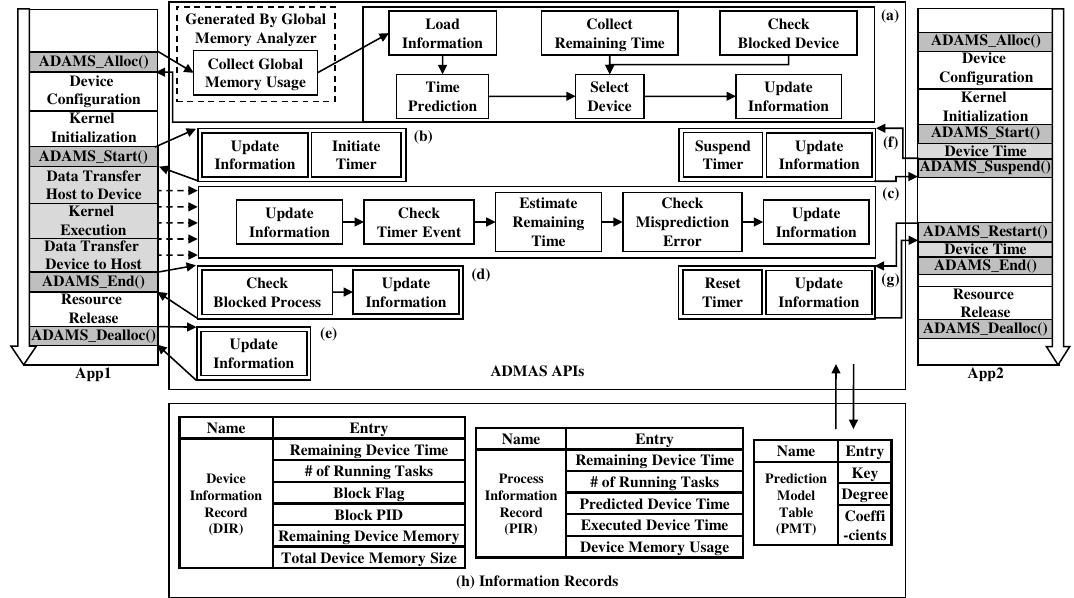
Figure 5. An overview of ADAMS framework, ( a – g ) API descriptions, ( h ) information